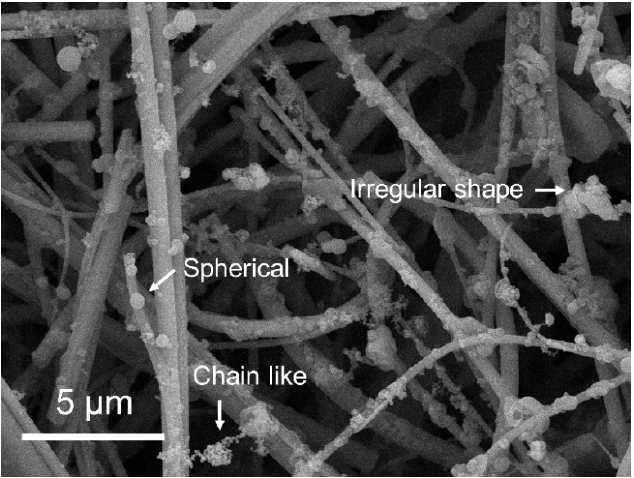
Figure 3. SEM image of PM 2.5 collected on a quartz fiber filter.